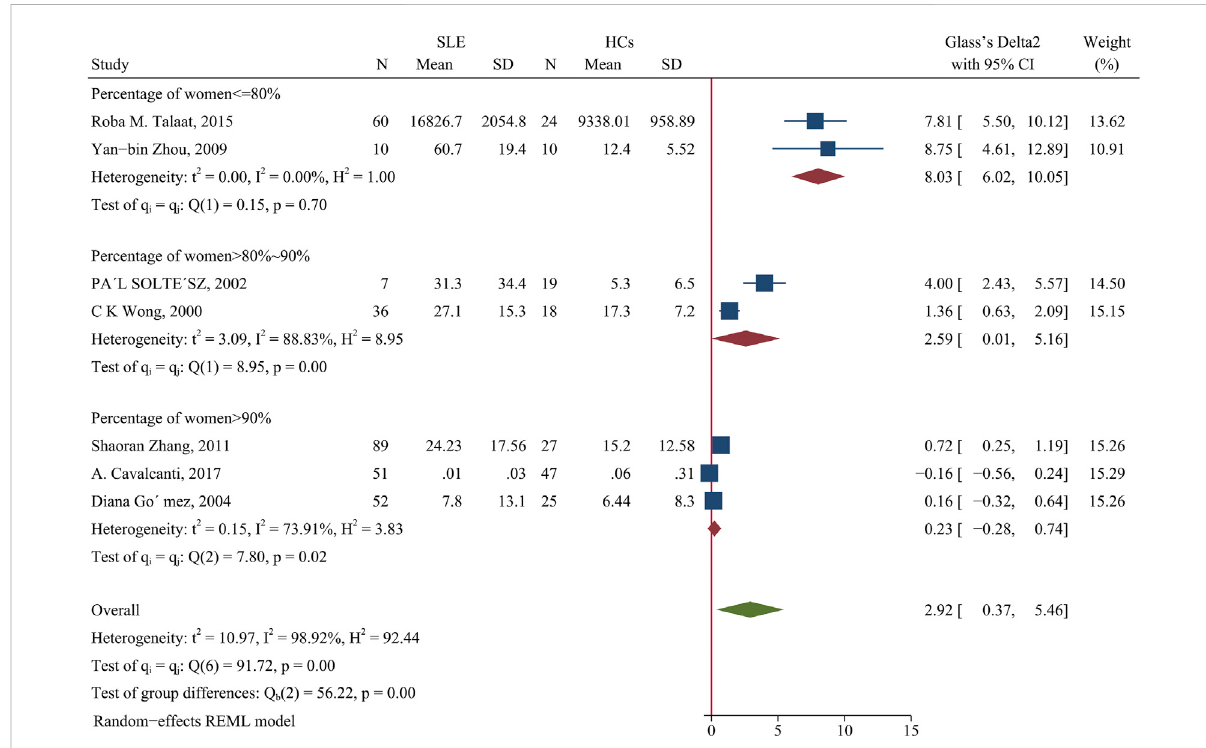
FIGURE 10 Forest plot of the concentration change of IL-4 in SLE patients compared with HCs. The overall results (bottom) show the meta-analysis of 7studies, andtheotherthreeresults showmeta-analysesofsubgroupsaccordingto thepercentageoffemales.SLE,systemic lupuserythematosus; HCs, healthy